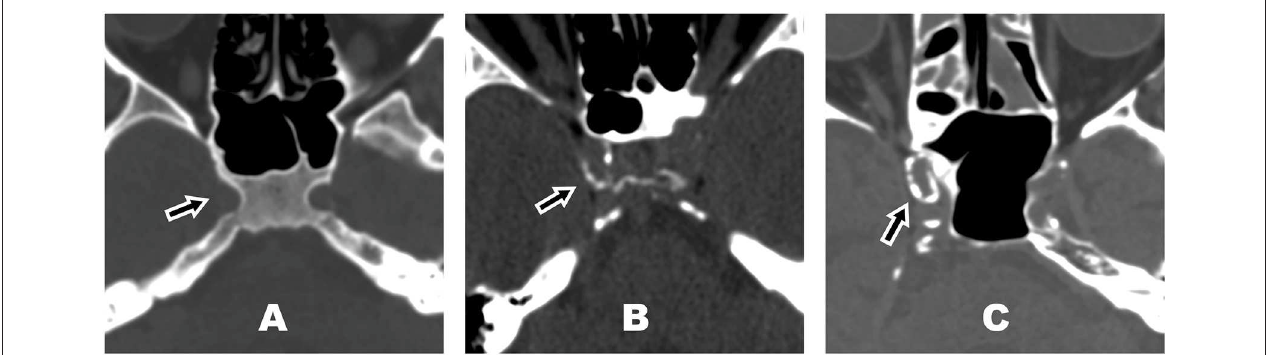
FIGURE 1 | Examples of different degrees of intracranial carotid artery calcification in the right carotid artery (arrow) on unenhanced bone-window computed tomography (CT) image. (A) Intracranial carotid artery calcification (ICAC) score = 0 (no calcification), (B) ICAC score = 2 (mild, 10–50% of the vessel circumference constituted of calcification), (C) ICAC score = 4 (severe, > 90% of the vessel circumference constituted of